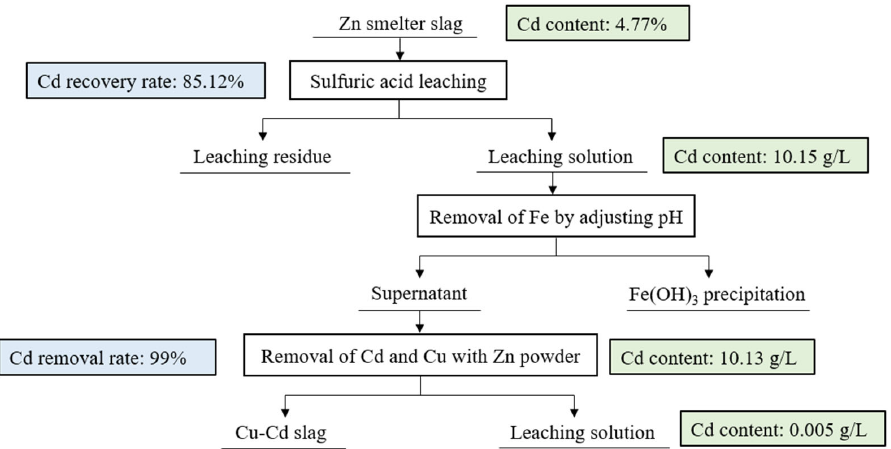
Figure 6. Zn Smelting Slag Valuable Metal Recovery Process. reproduced from [53], with permission from Elsevier, 2019.